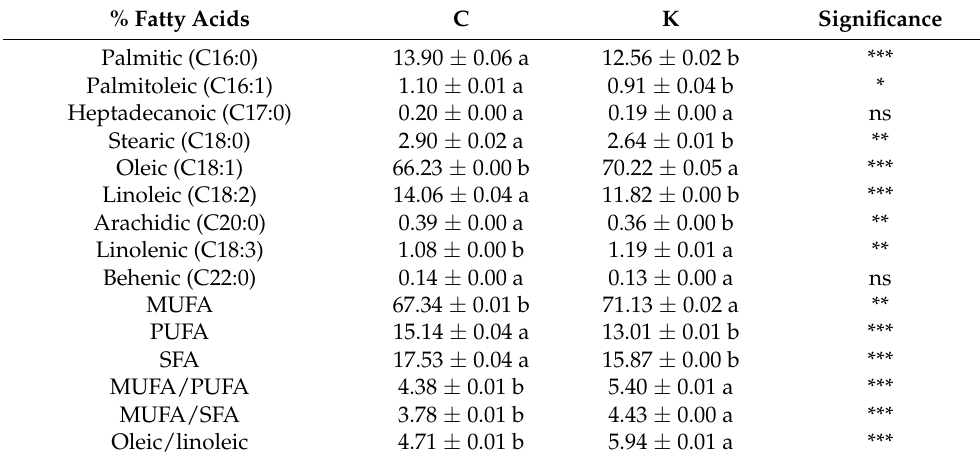
Table 5. Fatty acid composition of oil with kaolin treatment (K) compared with control